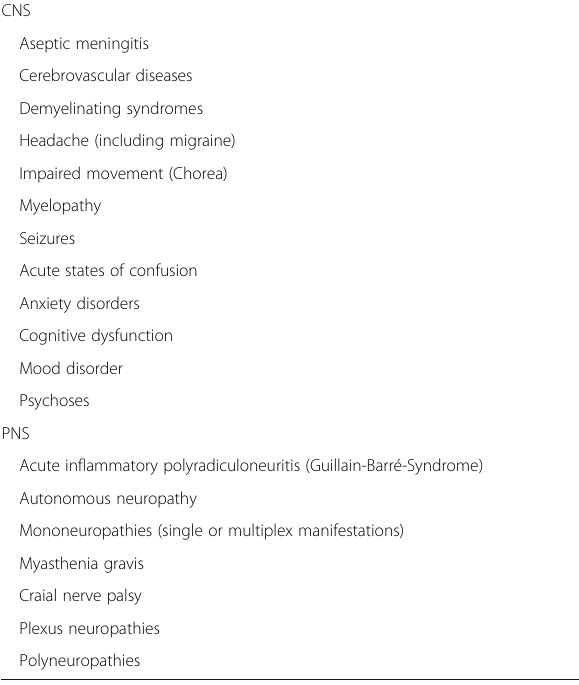
Table 6 Neuropsychiatric Syndromes in SLE (according to the American College of Rheumatology